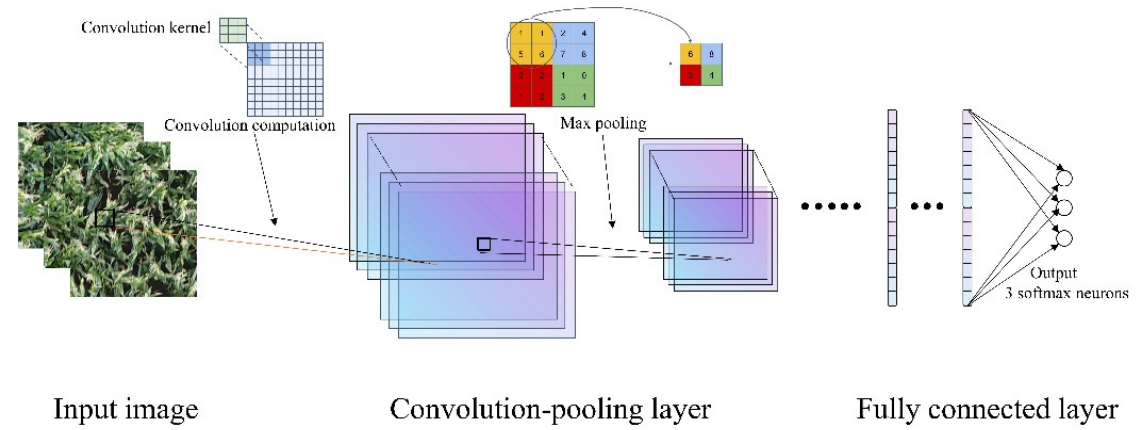
6 of 17 Figure 5. Original UAV image and three augmented images. 2.4. Deep Learning